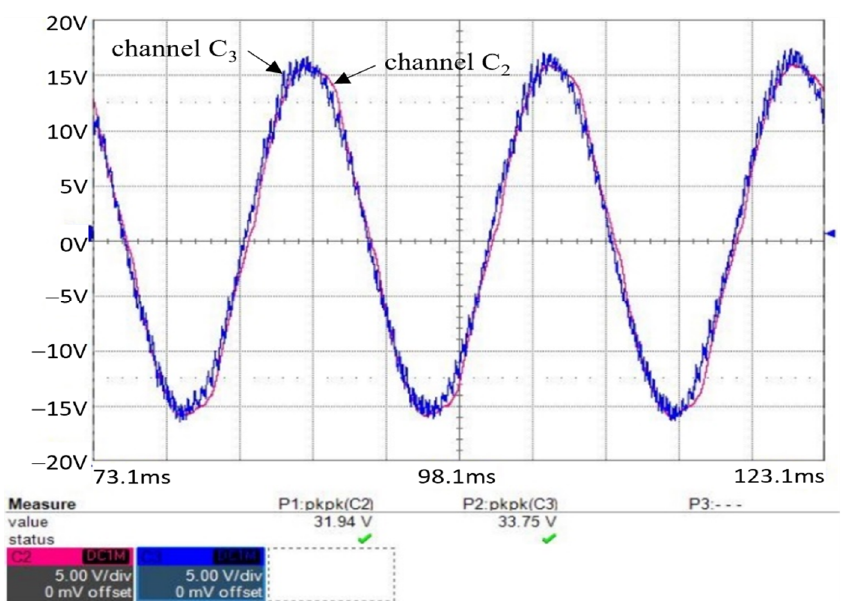
Figure 15. Synchronization test results .